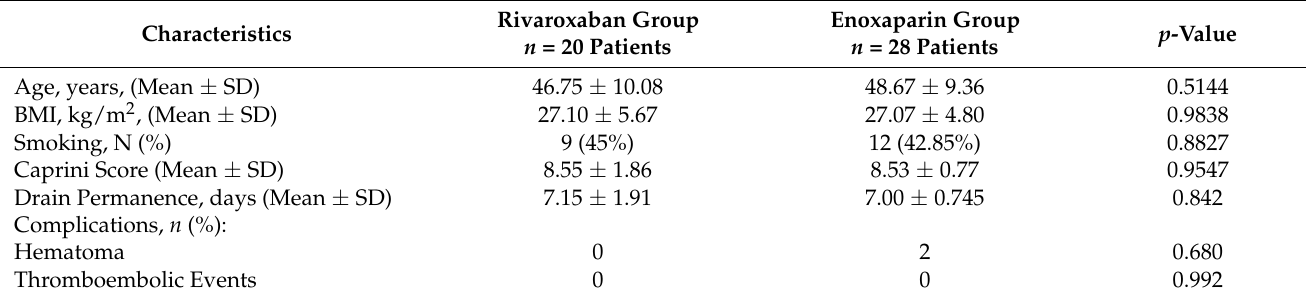
Table 1. Characteristics of the study population, according in antithrombotic